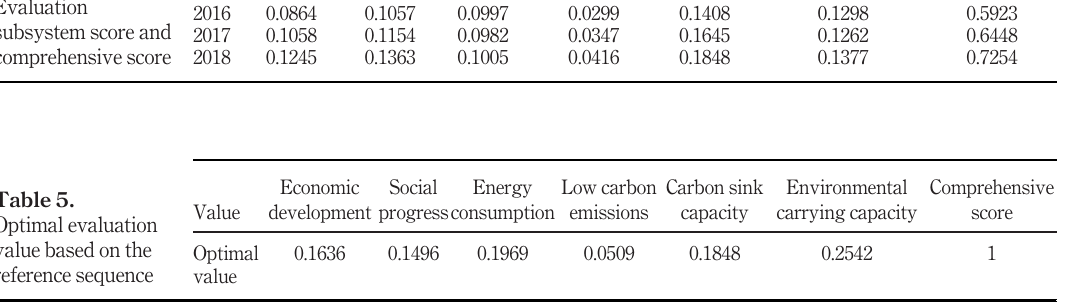
Table 4. Evaluation subsystem score and comprehensive score